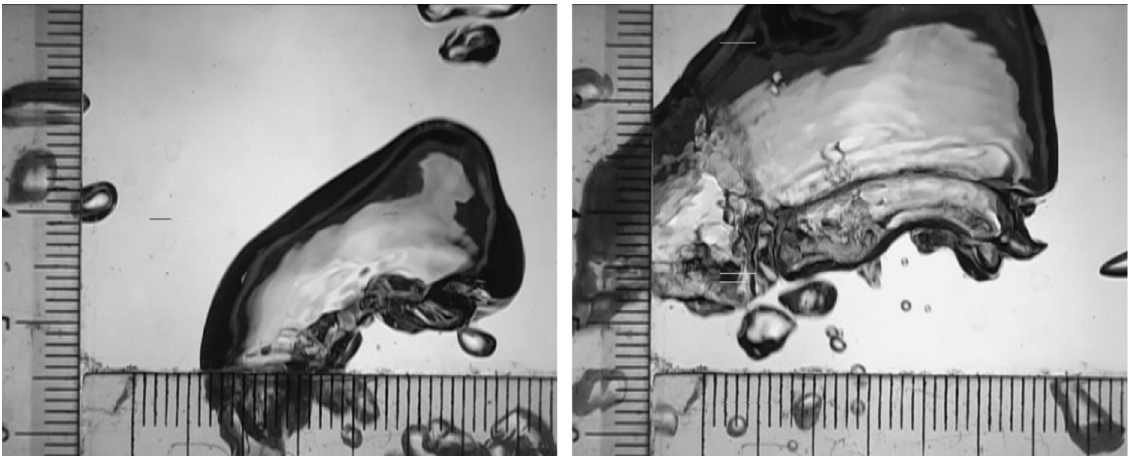
11 of 13 Figure A1. Examples of bubble size distributions in the laboratory tests. Appendix B